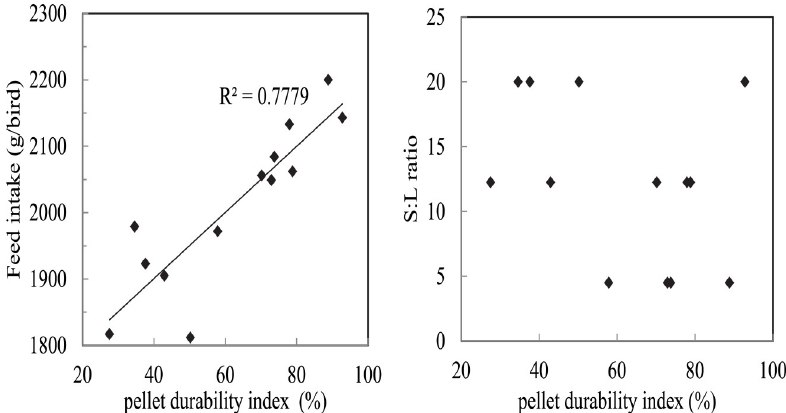
Fig 8. Linear regression between feed intake and pellet durability index (left) and the lack of correlation between dietary S:L ratios and pellet durability (right).